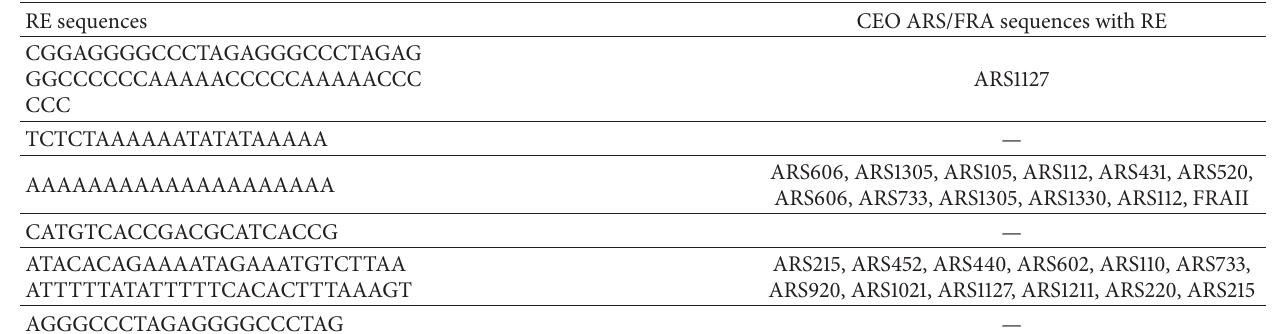
Figure 7: Nucleotide repeat pattern search in APS from other eukaryotes. Pattern search in the highest curvature regions of the APS isolated from plants, yeast, and human beings. The tetranucleotide repeats of “T” are shown in red ink, while those of “A” are shown in green ink. Table 9: Presence of RE sequences in APS of S. cerevisiae and